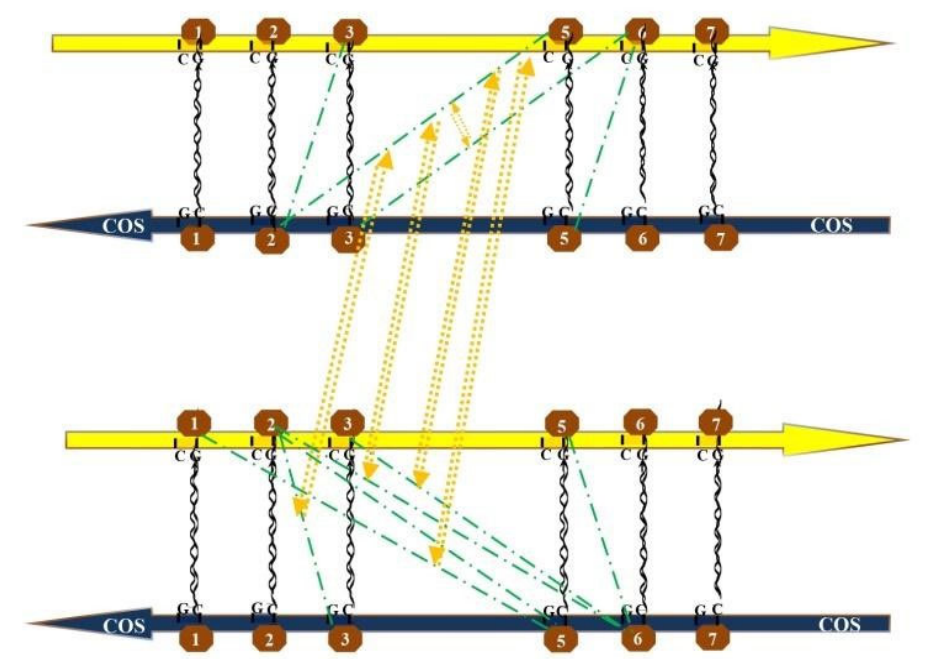
Figure 2. Graphic representation of significant recurrent interactions between all-specifically methy- lated CpG pairs, accounting for a tight interaction between cytosines placed one another at their left and giving clues for a rightward slip between the strands (see Figure 3). Each methylated pair is represented by the green point-line-point hatching, the correlations between pairs are drawn by the two-way dashed arrows in yellow.